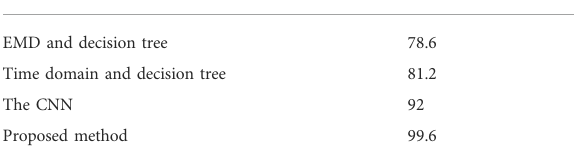
TABLE 6 Comparison with other